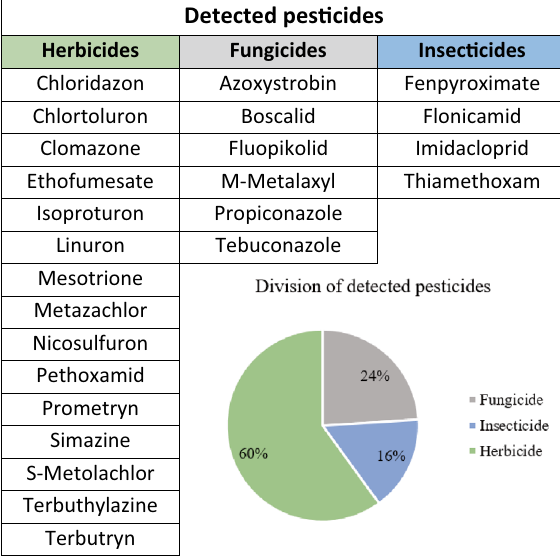
Figure 3. Detected pesticides divided into three groups: herbicides, insecticides, and fungicides.